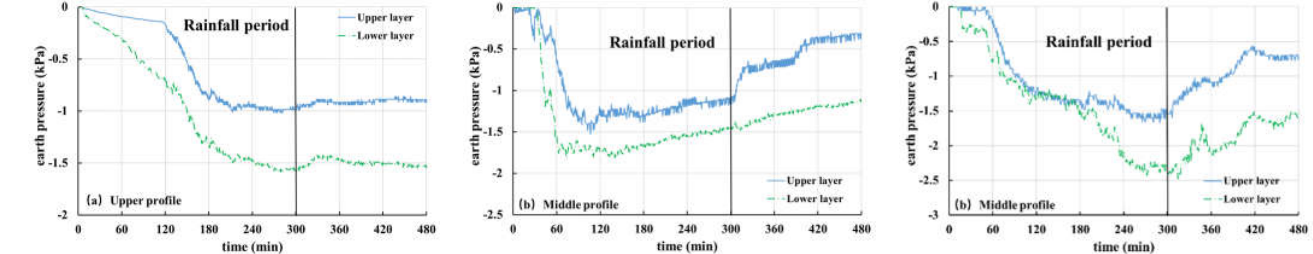
Figure 18. Curves of earth pressure in Test 5 (−, 30 mm/h): ( a ) upper profile; ( b ) middle profile; ( c ) lower profile.